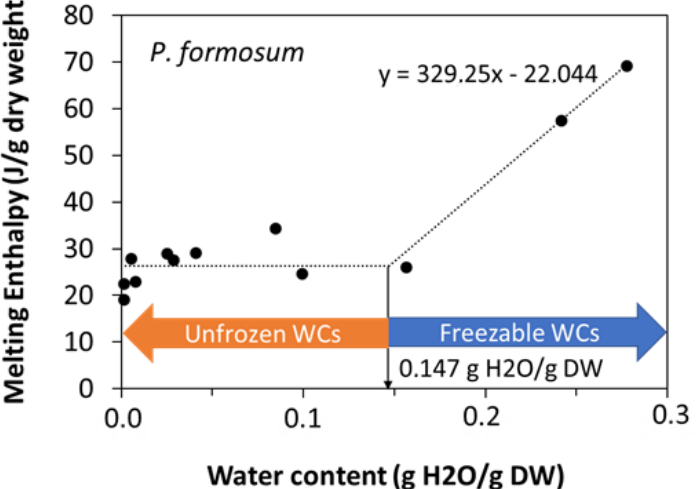
Figure 3. Relationship between water content (g H 2 O g − 1 DW) and enthalpy of melting transition (J g − 1 DW) measured for spores of 12 samples of Polytrichum formosum (acc. 1 and acc. 2) with diverse water content. The slope of the linear relationship of the two wettest samples (see equation in the figure panel) was used to calculate the ∆ H of the water melting or freezing transition on a g − 1 H 2 O basis. The intersection between this line and the horizontal line attributed to the TAG transitions shows the exact point below which melting or freezing transition cannot be observed [40].